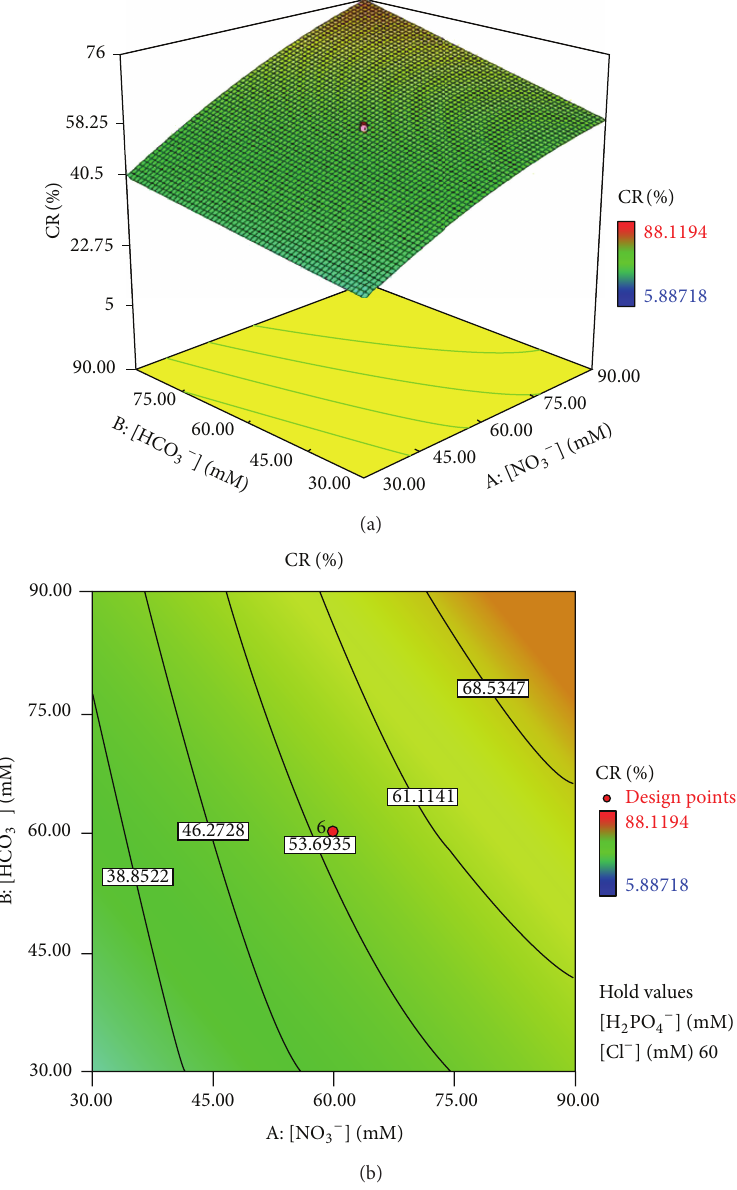
Figure 3: Response surface (a) and contour plots (b) of the removal efficiency (%) as a function of NO 3− and HCO 3− concentration.